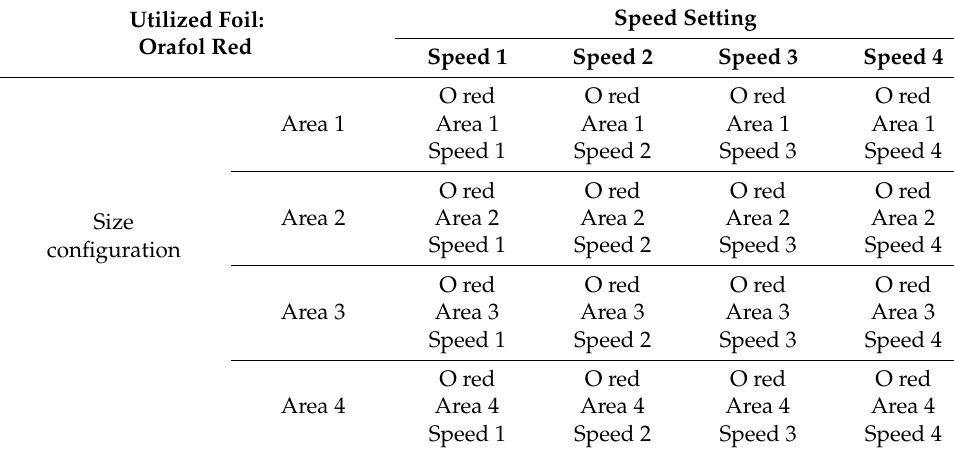
Table 4. Example of the different classes generated for the Orafol red foil. Utilized